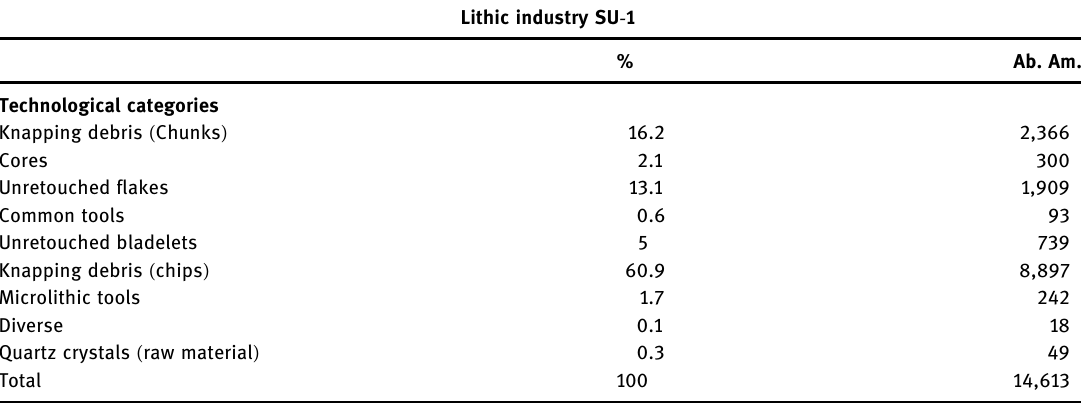
Lithic industry SU - 1